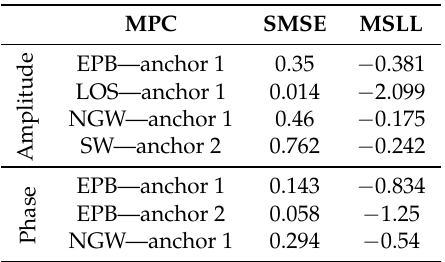
Figure 4. GP prediction of SMC amplitude for ( a ) the LOS amplitude associated with anchor 1 at a ( 1 ) ( b ) the SMC amplitude of VA at a ( 1 ) associated with anchor 1 (east plaster board wall), ( c ) the SMC 2 amplitude of VA at a ( 1 ) associated with anchor 1 (north glass window), ( d ) the SMC amplitude of VA 5 a ( 2 ) associated with anchor 2 (south wall). 3 Table 2. Prediction